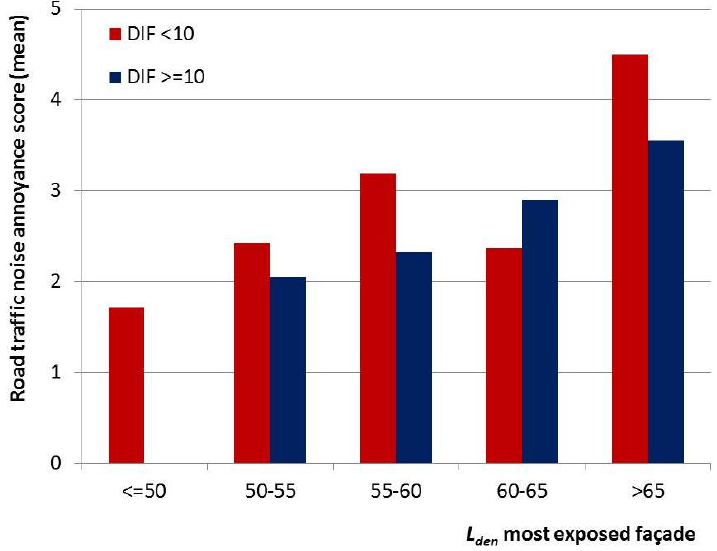
Figure 2. Mean annoyance score (scale 0 to 10) in the Amsterdam study population for two categories of difference between most and least exposed façade (DIF < 10 dB versus DIF ≥ 10 dB), using 5 dB intervals of L . den,most